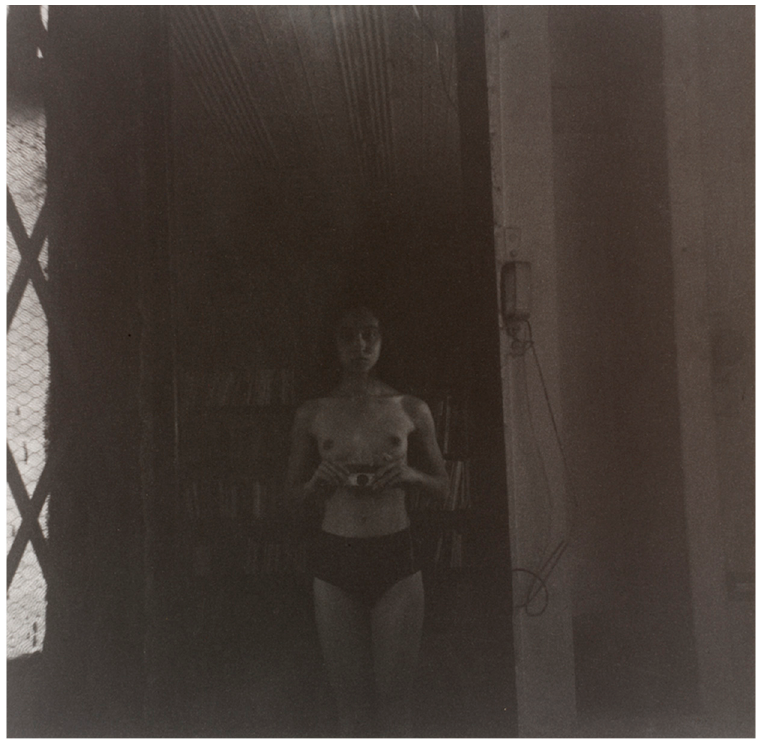
Figure 8. Adrian Piper, Food for the Spirit , 1971, Selenium toned gelatin silver print, 14 ½ × 14 ¾ Courtesy of the RISD Museum, Providence, RI.